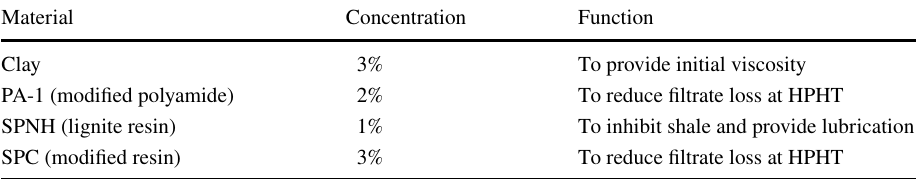
Table 2 Base mud formula